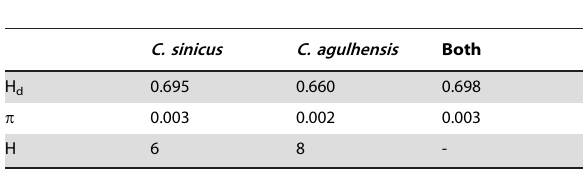
Table 3. Diversity measures of mtCOI sequence